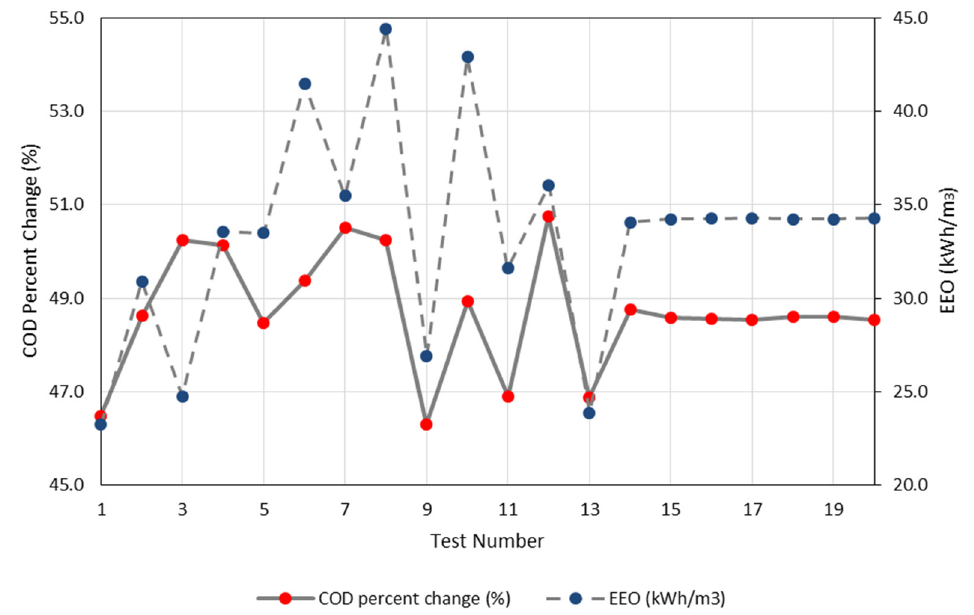
Figure 4. Comparison of COD percent change with electrical energy order over the 20 tests mentioned in Table 3.